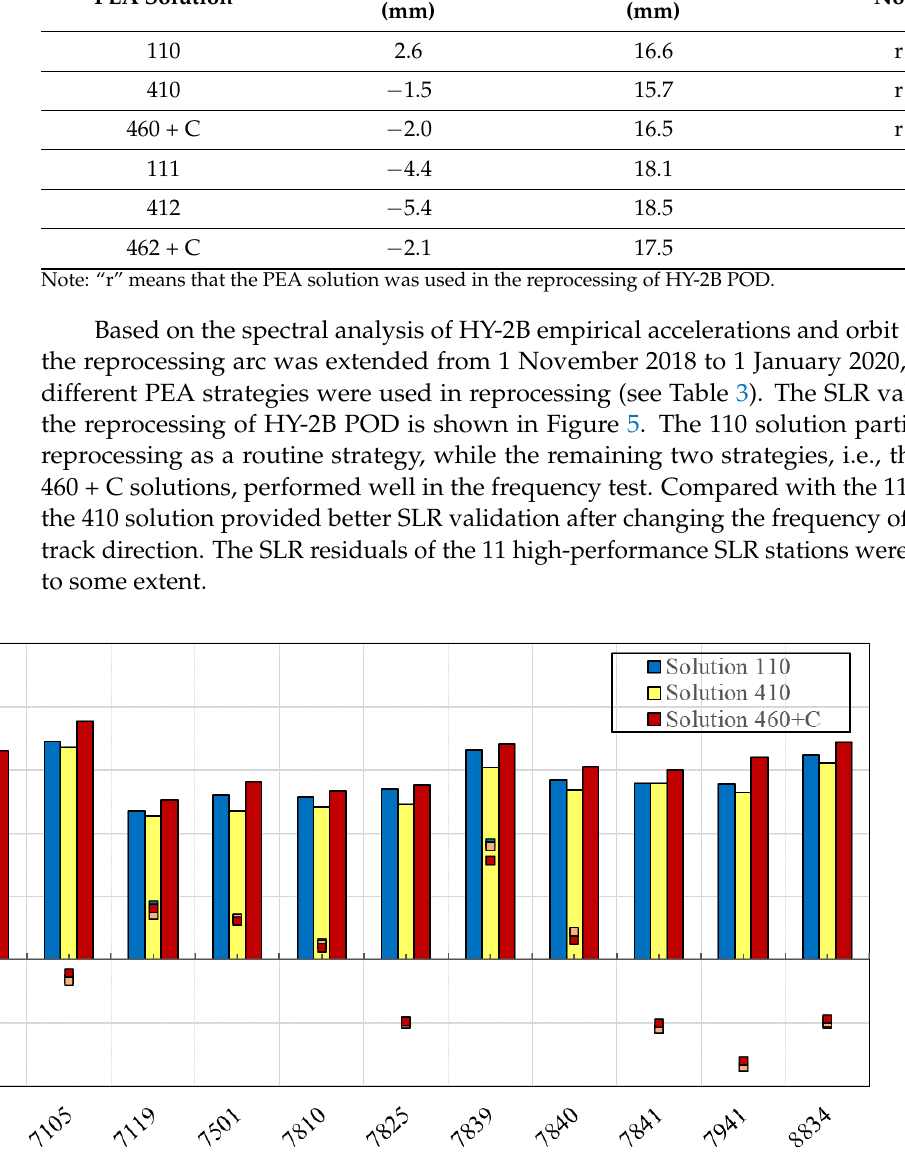
Figure 5. Statistics of the SLR residuals for individual SLR sites for three reprocessing strategies. The square is mean bias for each contributing station.